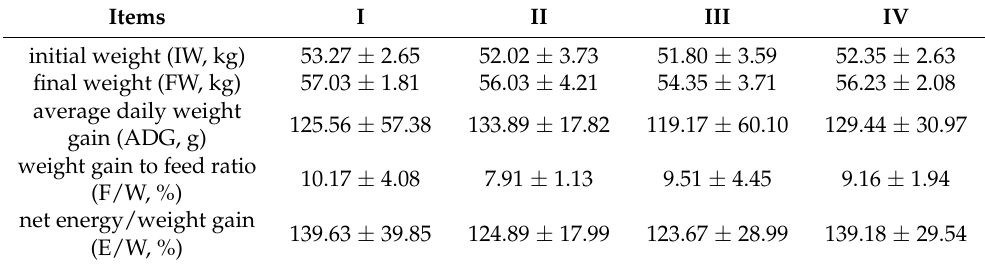
Table 4. Effects of dietary supplementation with different inclusion of SMS-MP on growth perfor- mance of growing sika